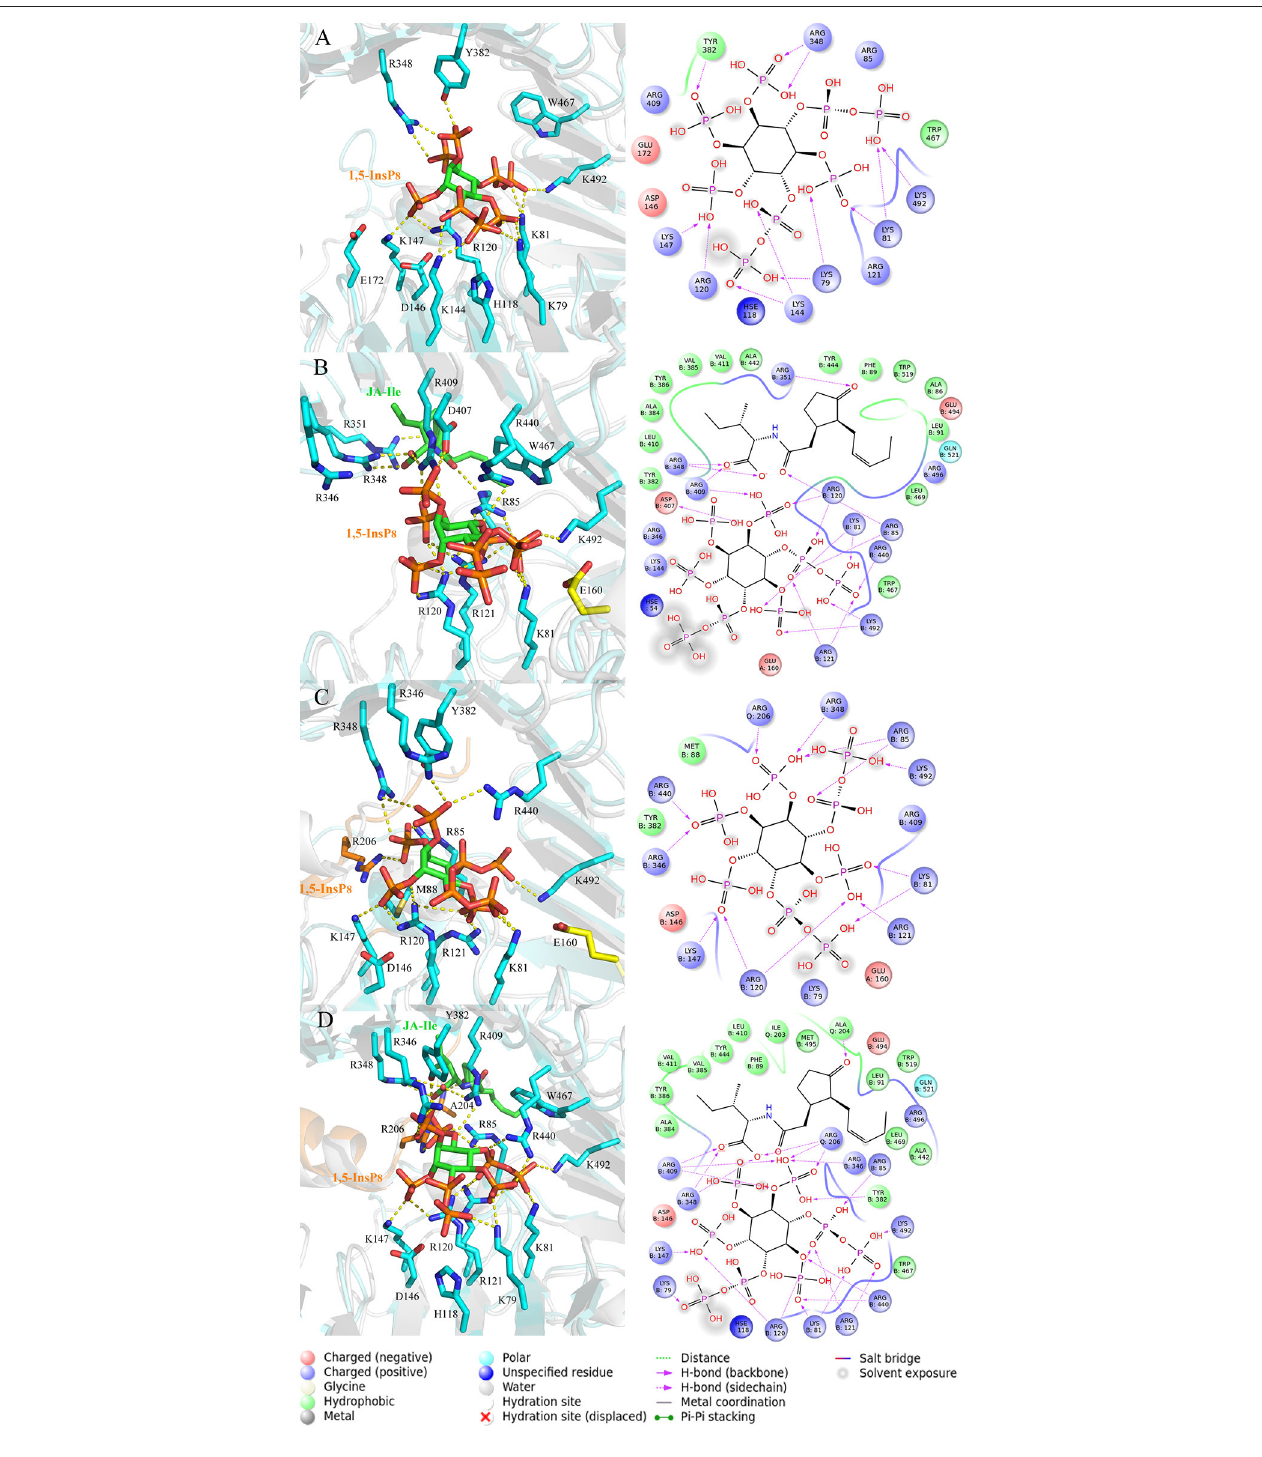
FIGURE 7 | The representative snapshots from the last 20 ns of the MD trajectories. (A) system 2, COI1 + ASK1 + 1,5-InsP 8 ; (B) system 3, COI1 + ASK1 + 1,5-InsP 8 + JA-Ile; (C) system 5, COI1 + ASK1 + JAZ1 + 1,5-InsP 8 ; (D) system 6, COI1 + ASK1 + JAZ1 + 1,5-InsP 8 + JA-Ile. For panels (A–D) , the proteins are in white and cyan for the docked and MD structures, respectively. Hydrogens are omitted for clarity.